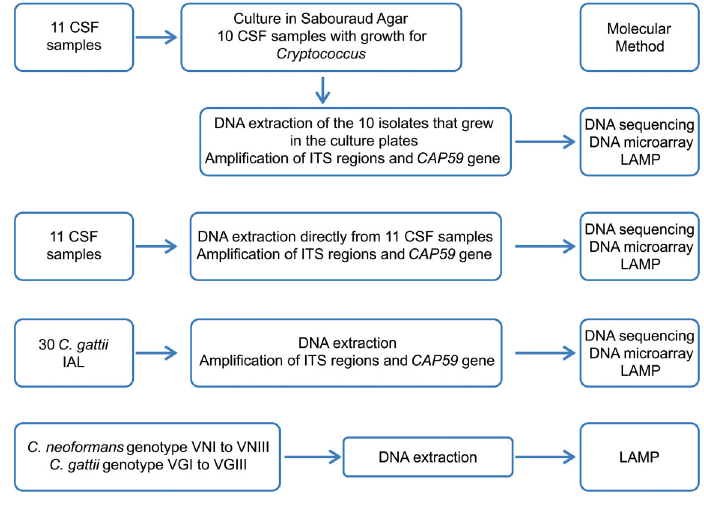
Figure 1. Flowchart of the molecular experiments using cerebral spinal fl uid from patients with cryptococcal meningitis, Cryptococcus gattii isolates, and DNA samples of Cryptococcus spp. ITS: internal transcribed spacer; IAL: Instituto Adolfo Lutz; CSF: cerebral spinal fl uid; LAMP: loop-mediated isothermal ampli fi